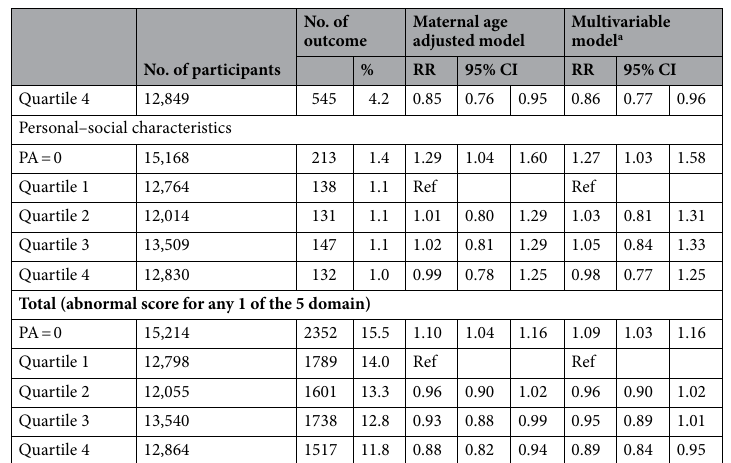
Table 3. Association between physical activity during pregnancy and infant sleep and development, Japan Environment and Children’s Study (2011–2014). PA physical activity, CI confidence interval, RR risk ratio, Ref reference. a Adjusted for maternal age at delivery, smoking habits, alcohol consumption, pre-pregnancy body mass index, gestational age at birth, parity, infertility treatment, infant sex, type of delivery, psychological distress at 1 year after delivery, doctor diagnosis of asthma and atopic dermatitis at 1-year-old, and feeding status.